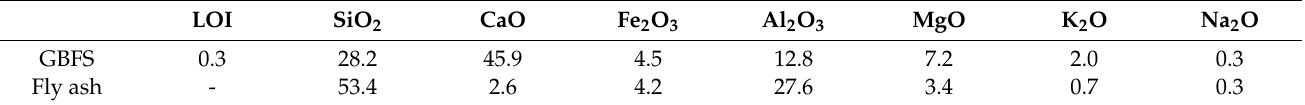
Figure 1. XRF spectra of fly ash and granulated blast furnace slag (GBFS). Table 2. Chemical composition of GBFS and fly ash used as main raw material (% by mass).